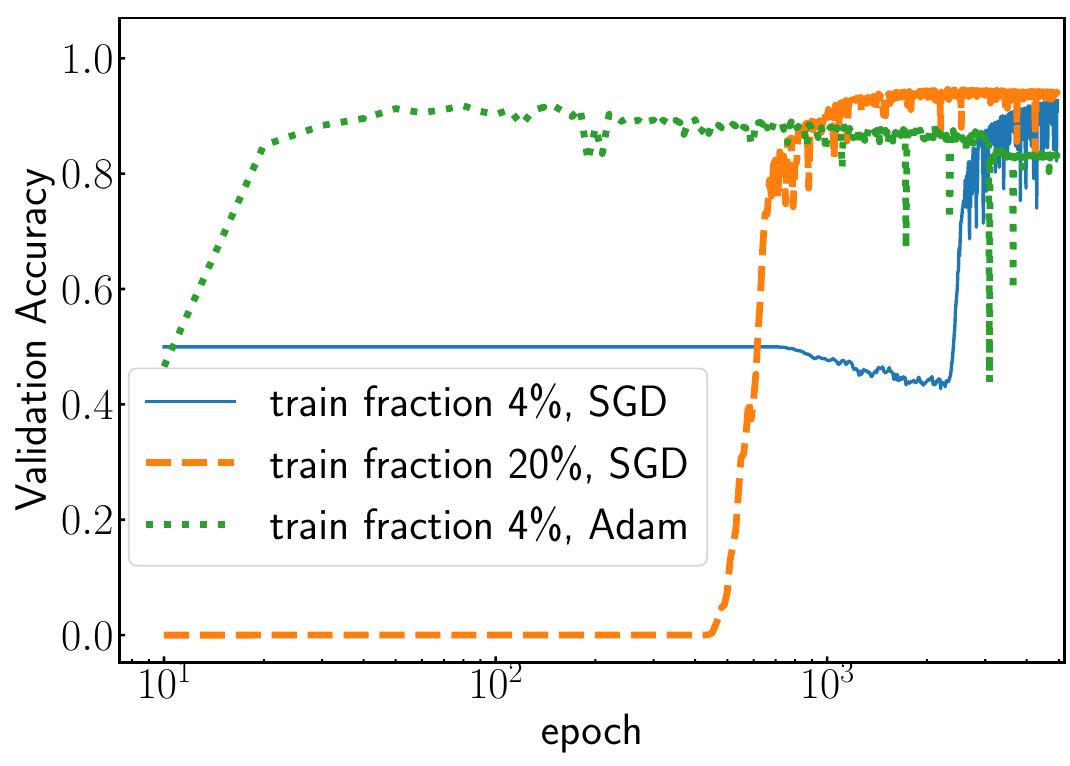
Figure 6 . Validation loss during 5000 epochs of training for di(cid:11)erent training data fractions and optimizers in Au+Au central collisions generated within UrQMD at p s = 7 GeV. Solid and dashed curves indicate the results obtained by SGD method with train fraction 4% and 20%, respectively. Dotted curve denote the results obtained by Adam method with 4% train